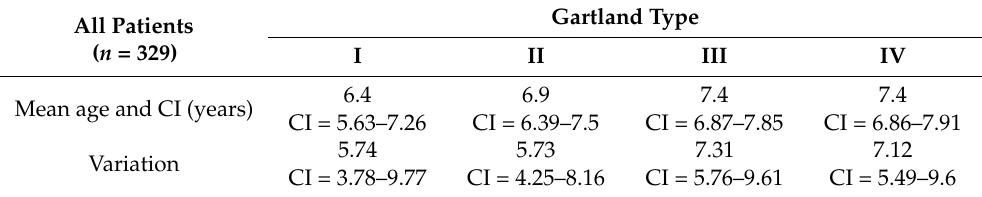
Table 7. Mean value and variation of patients’ ages per Gartland type.